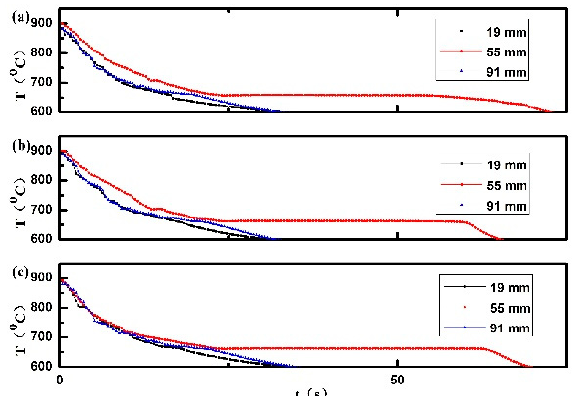
Figure 6. Cooling curves measured during solidification of pure aluminum: ( a ) without electropulsing; ( b ) under an alternating electropulsing with 480 A and 50 Hz and ( c ) under an alternating electropulsing with 900 A and 50 Hz.